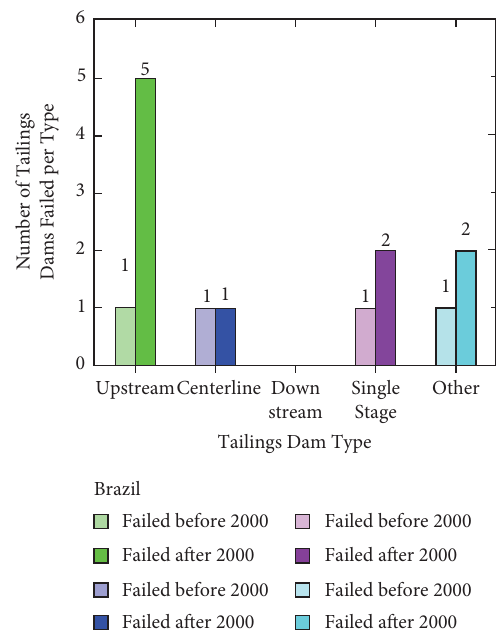
Figure 4: Number of tailings dams failed per tailings dams built in Brazil, before and after 2000, according to dam type (data from Bowker [22] and Agˆencia Nacional de Mineração [26]).